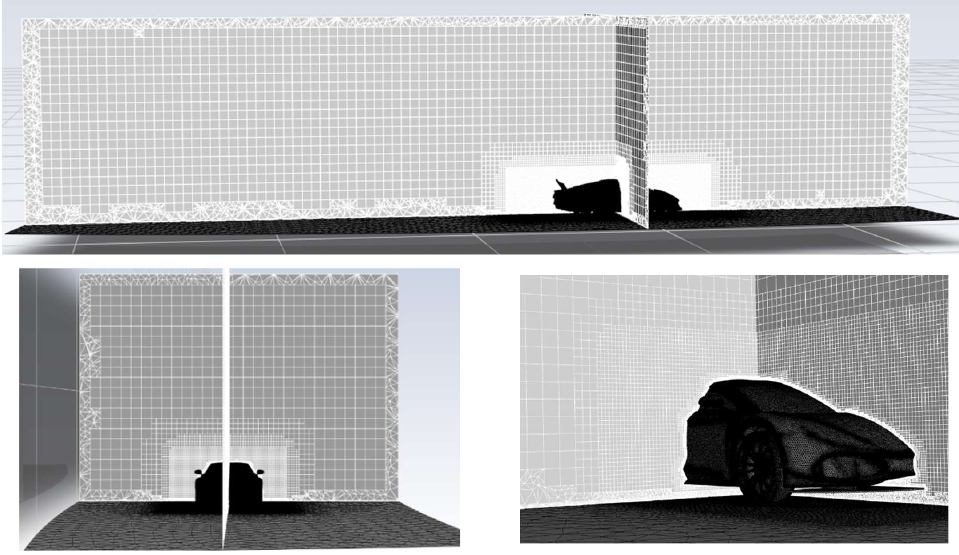
Figure 5. Exemplary mesh.